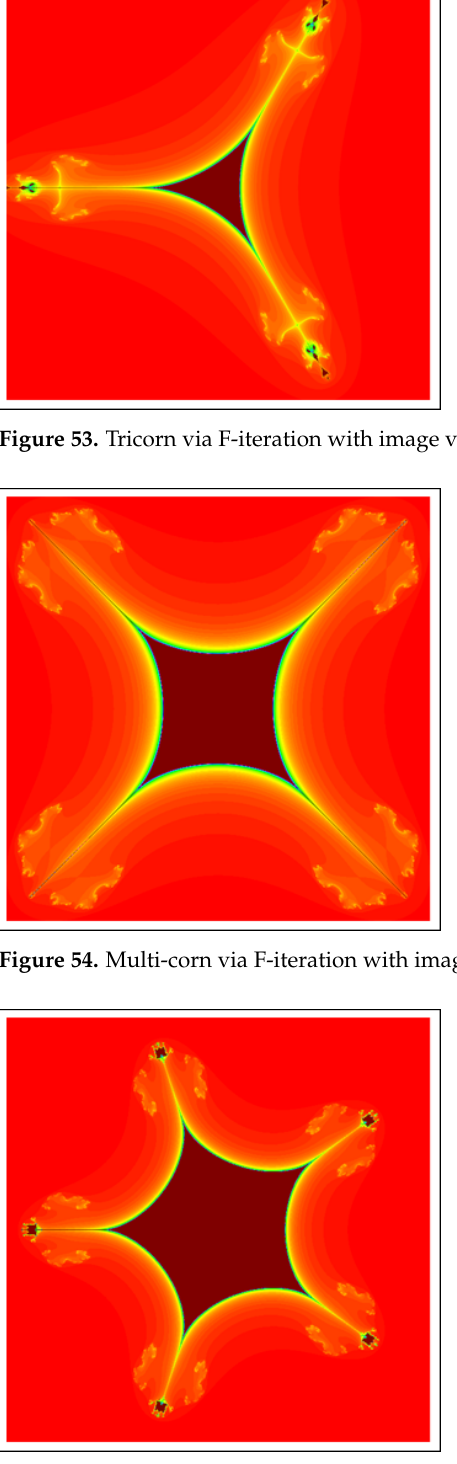
Figure 55. Multi-corn via F-iteration with image visual time = 66.1